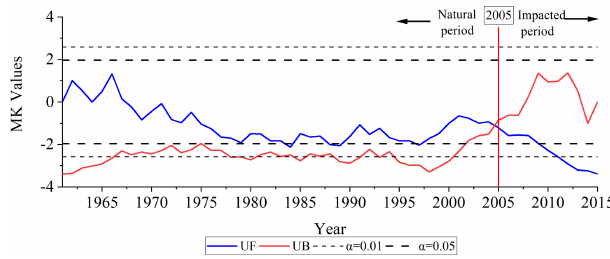
Figure 4. The Mann–Kendall break point testing statistics of the annual streamflow for the LR basin from 1961 to 2015.